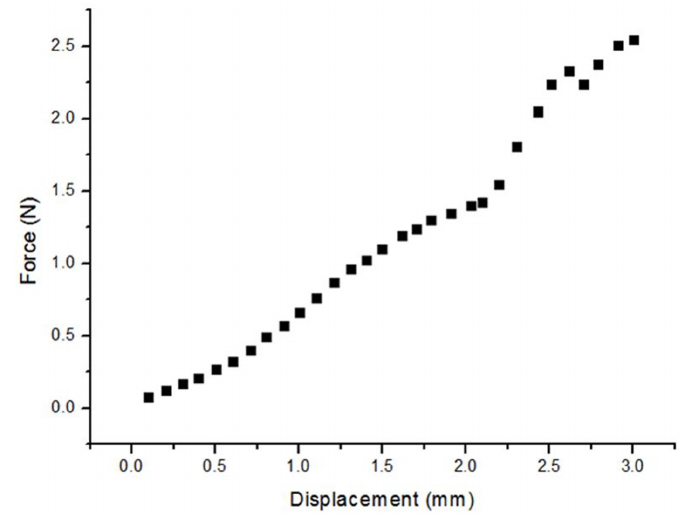
Figure 8. The relationship between force and